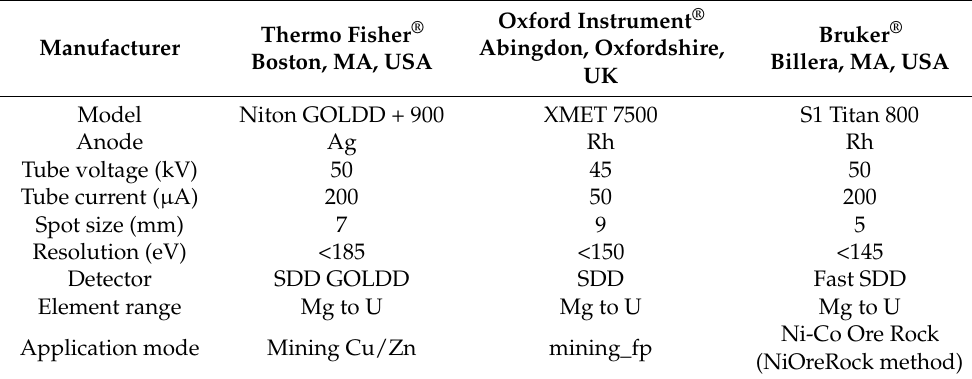
Table 1. Specifications of the instruments used in this